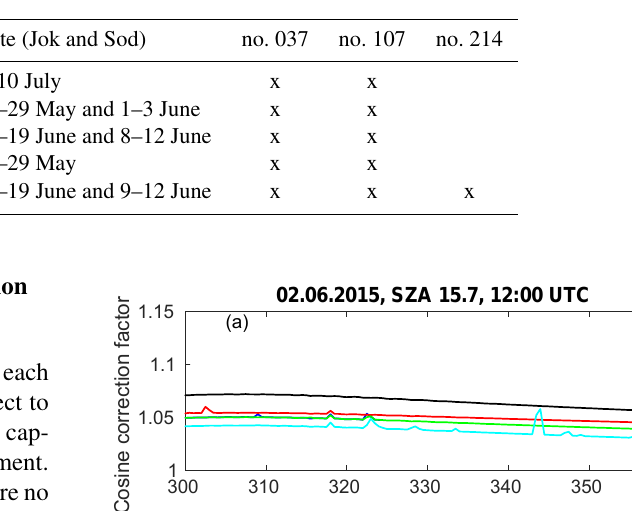
Table 4. QASUME site audits of the Brewers of FMI. Date (Jok and Sod) signifies dates at Jokioinen and Sodankylä.